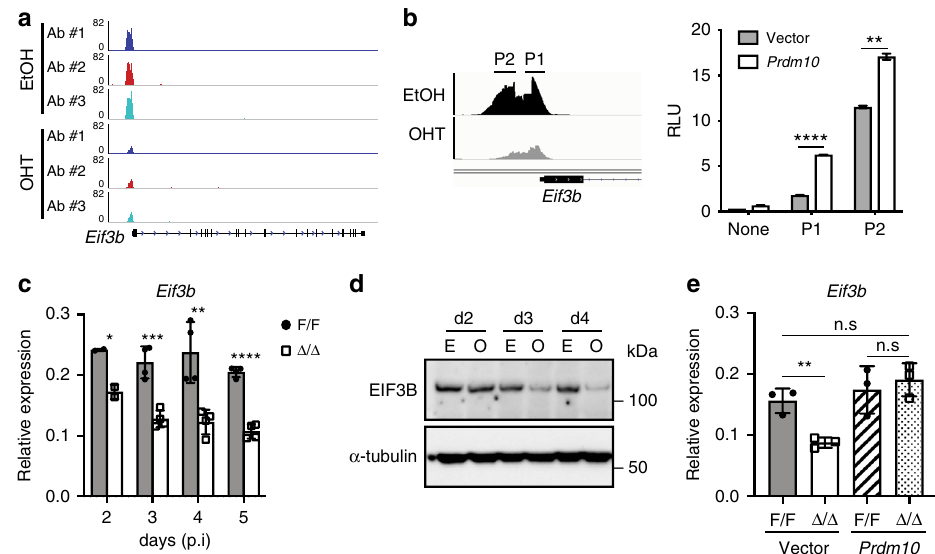
Fig. 5 PRDM10 transcriptionally regulates Eif3b expression. a ChIP-seq signal tracks showing PRDM10 occupancy at the Eif3b promoter in EtOH- vs. OHT-treated Prdm10 F/F ; CreER T2 mESCs, analyzed at 2 days post-induction. Vertical axis: fold-change over input. b PRDM10 enrichment at the Eif3b promoter is detected as two subpeaks, denoted P1 and P2 ( left ). PRDM10-dependent activation of luciferase reporters containing Eif3b promoter sequences derived from subpeak P1 or P2 ( right ); n = 2 samples. Representative data shown from one out of three independent experiments. c qRT-PCR quanti fi cation of changes in Eif3b transcript at indicated time-points after Prdm10 deletion; n = 2 – 3 biological replicates. d Western blot analysis of EIF3B protein levels in Prdm10 F/F ; CreER T2 mESCs at indicated time-points after treatment with EtOH (E) or 4-OHT (O). e qRT-PCR analysis showing restoration of Eif3b transcript levels in Prdm10 Δ / Δ mESCs by exogenous Prdm10 . Data shown at Day 4 post-induction; n = 3. Gene expression shown relative to Ubb ( c and e ). Error bars denote mean ± s.d.; * P < 0.05, ** P < 0.01, *** P < 0.001, **** P < 0.0001, n.s., not signi fi cant; two-tailed unpaired Student ’ s t test ( b , c and e